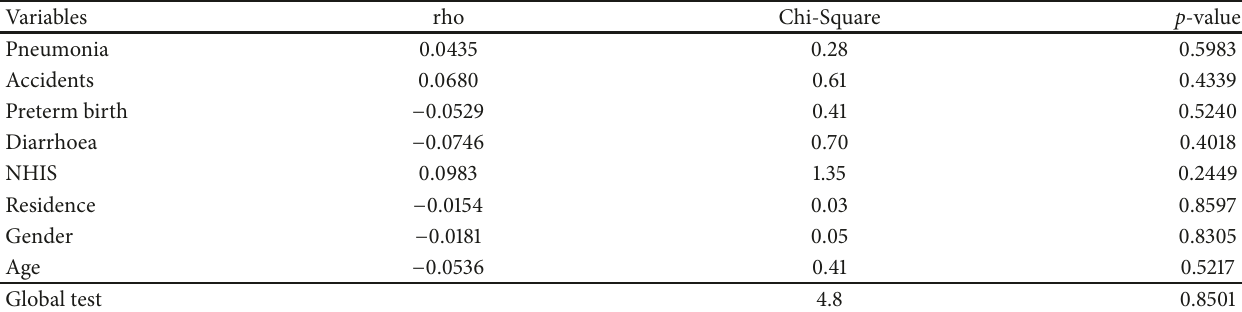
Table 3: Child mortality: test of Cox proportional hazard model assumption.